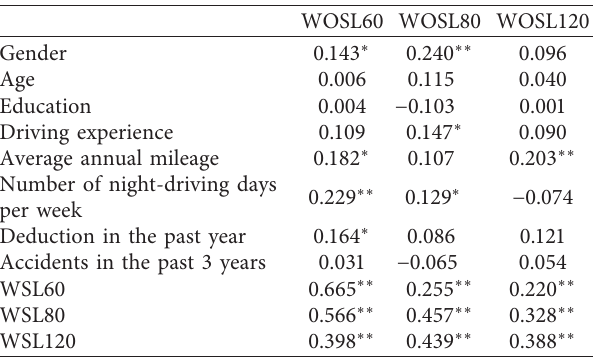
for WOSL80 is 16.9% ( F (9,233) � 10.977, p � 0 . 000) and 4% ( F (10,232) � 11.818, p � 0 . 000), respectively, indicating that